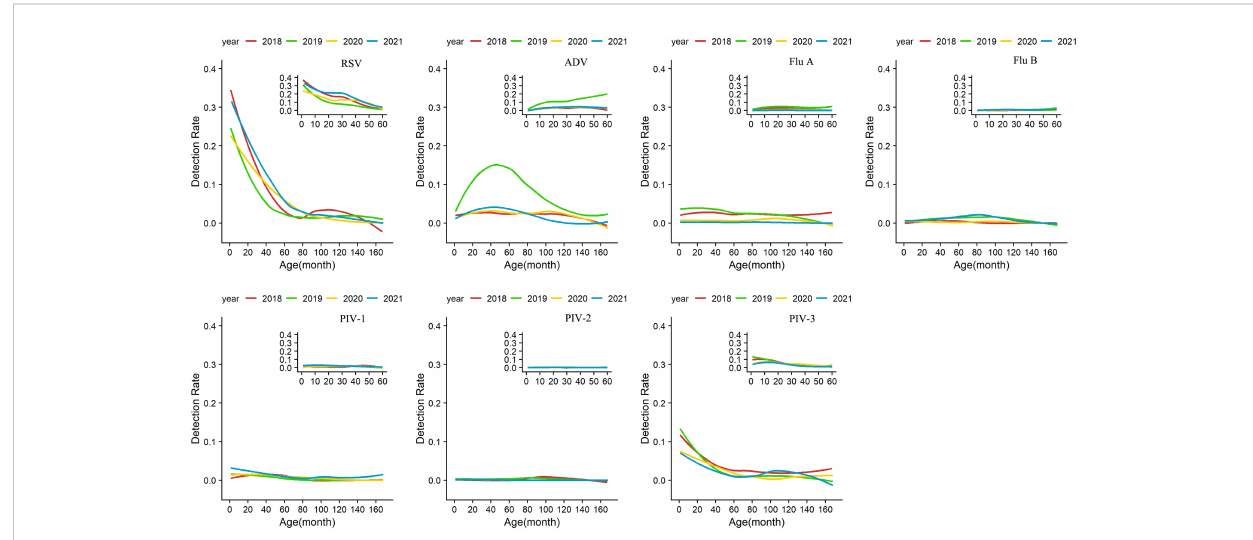
FIGURE 3 Age-speci fi c detection rates of viruses from January 1, 2018 to December 31, 2021. Seven respiratory viruses were included: respiratory syncytial virus (RSV), adenovirus (ADV), in fl uenza virus A and B (Flu A, Flu B), and parain fl uenza virus types 1 – 3 (PIV1 – 3).